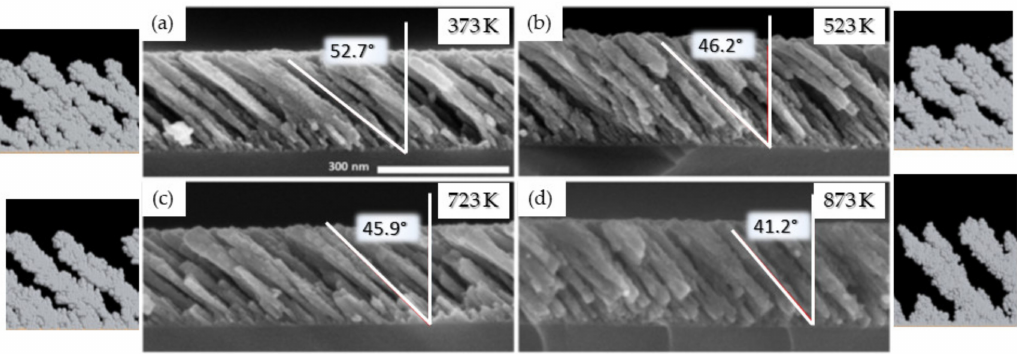
Figure 8. Ti thin films synthesized at 150 W, 0.13 Pa, and 85 ◦ for various substrate temperatures: ( a ) 373; ( b ) 523; ( c ) 723; ( d ) 873 K with the corresponding simulations. The red angle accounts for the average columnar tilt angle ( β ) estimated by over 20 columns (adapted from [50] with permission from Elsevier, 2017).